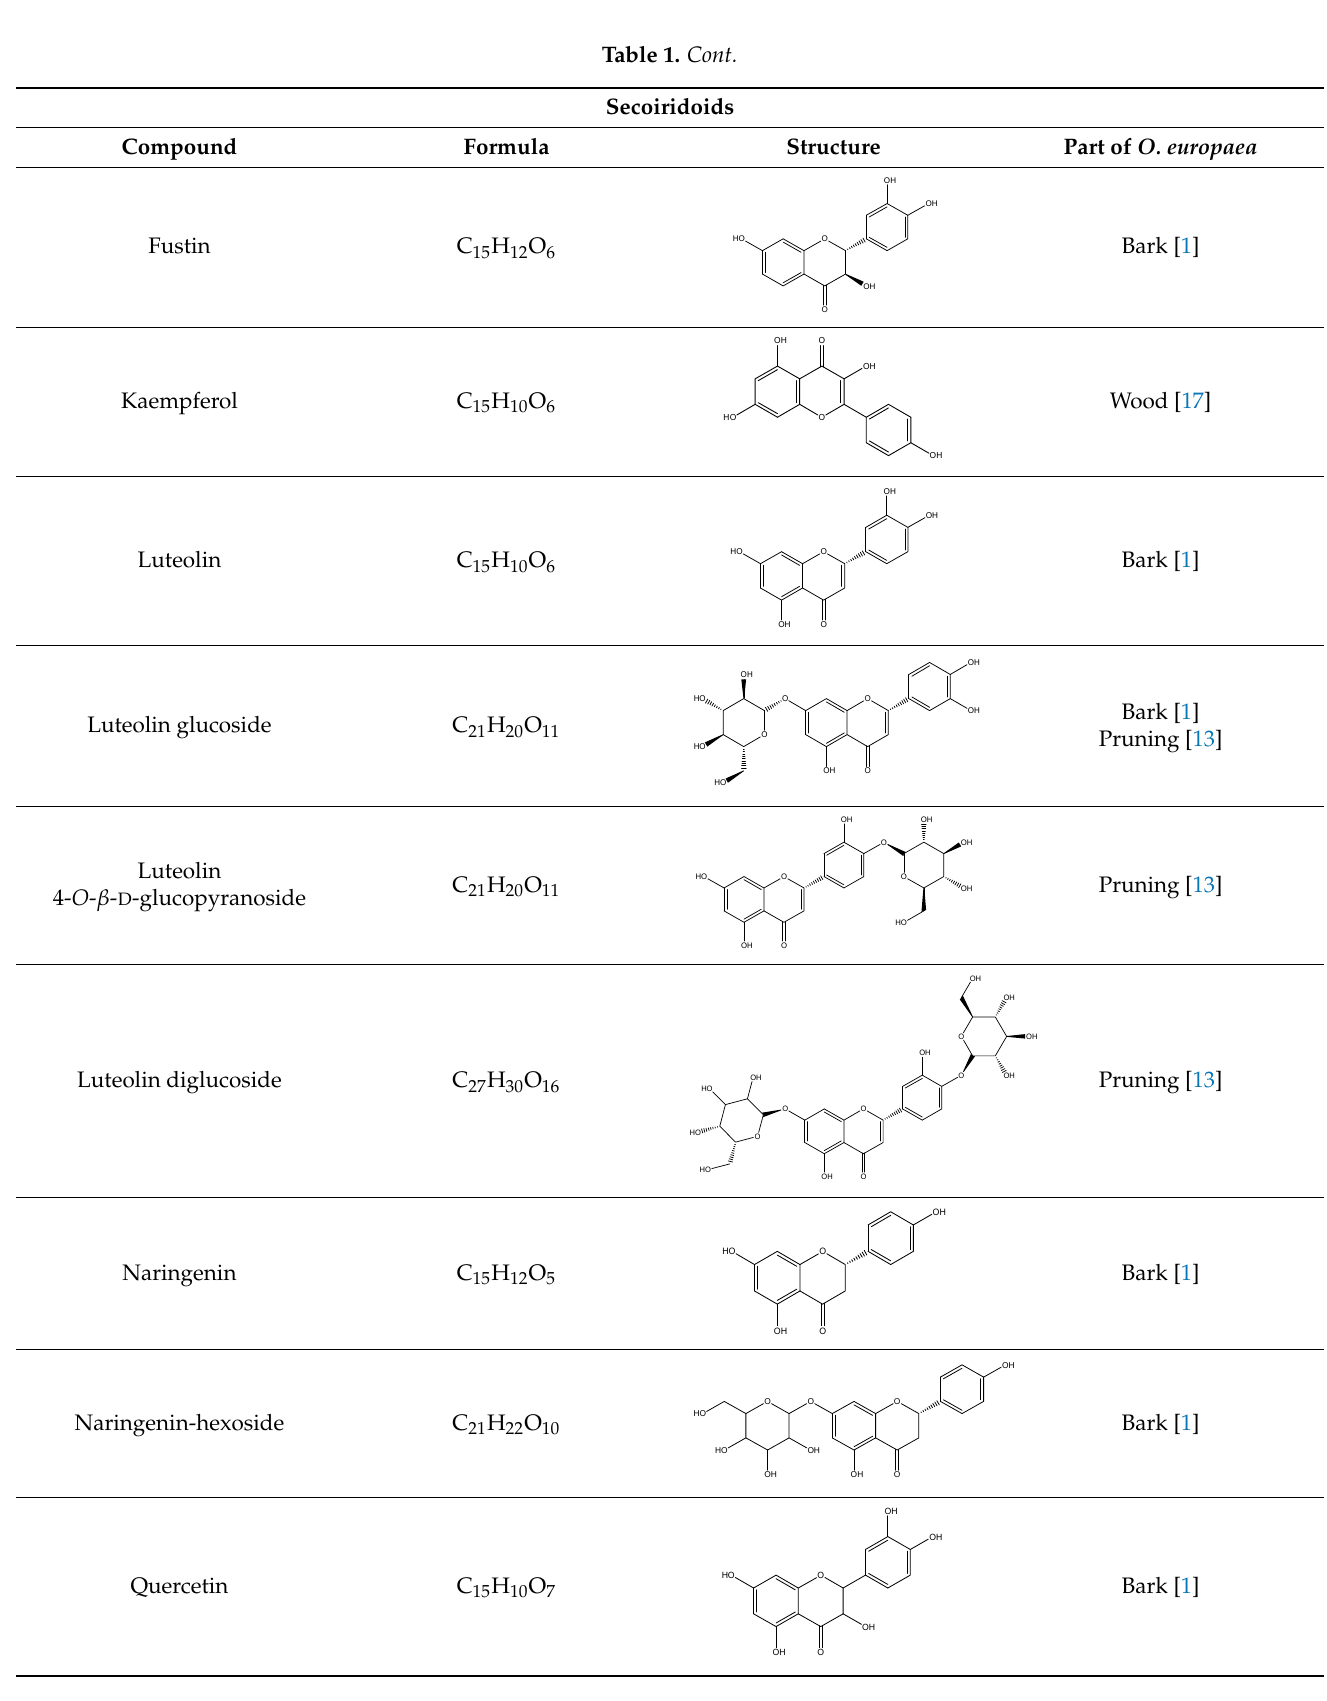
Table 1. Cont. Secoiridoids